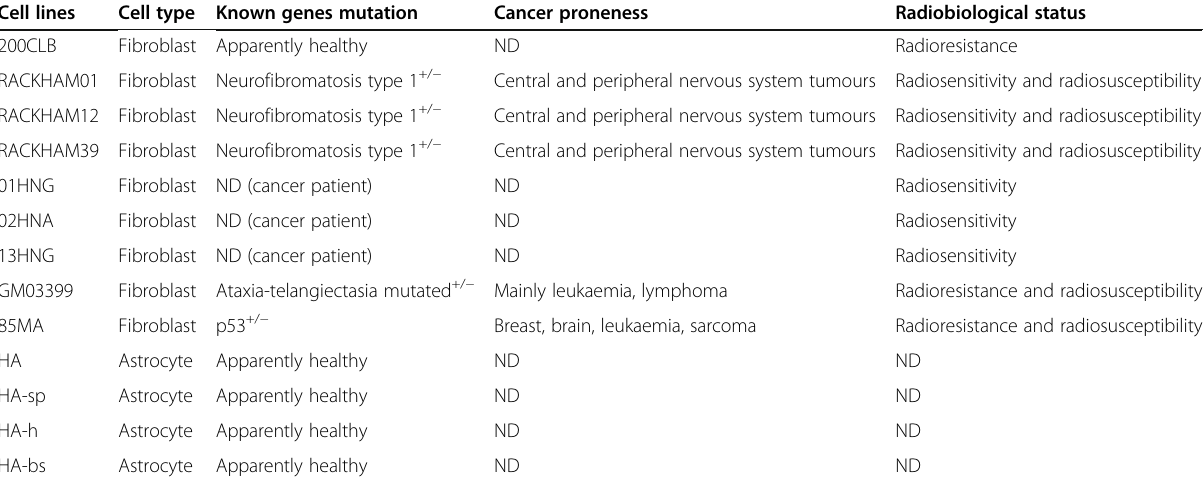
Table 1 Major clinical features of the cell lines used in this study Cell lines